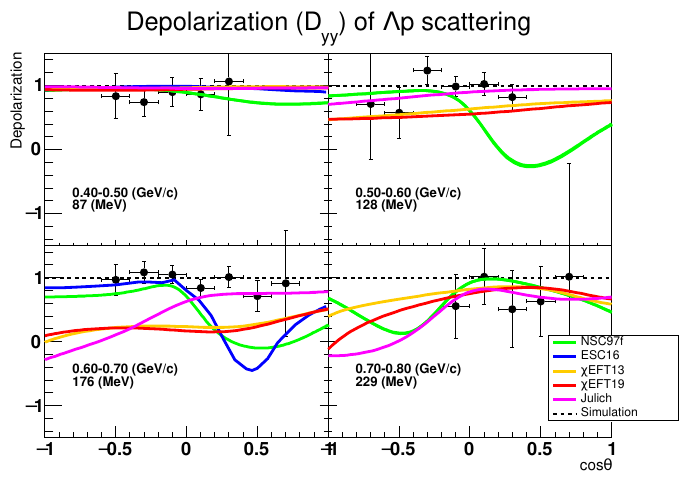
Figure 2. Expected D y y accuracy for 10 8 Λ beam. In this simulation, no spin transfer ( D y y = 0) and no induced polarization ( P = 0) in the Λ p scattering are assumed for simplicity. The beam polarization of P Λ = 1 is also assumed based on the past measurement. Theoretical calculations are also shown together. Due to the limitation of the statistics, errors in the high momentum region (0.7-0.8 GeV / c ) are still large. However, in the middle momentum region (0.5 to 0.7 GeV / c ) model di ff erence between the chiral EFT and Nijmegen models can be clearly